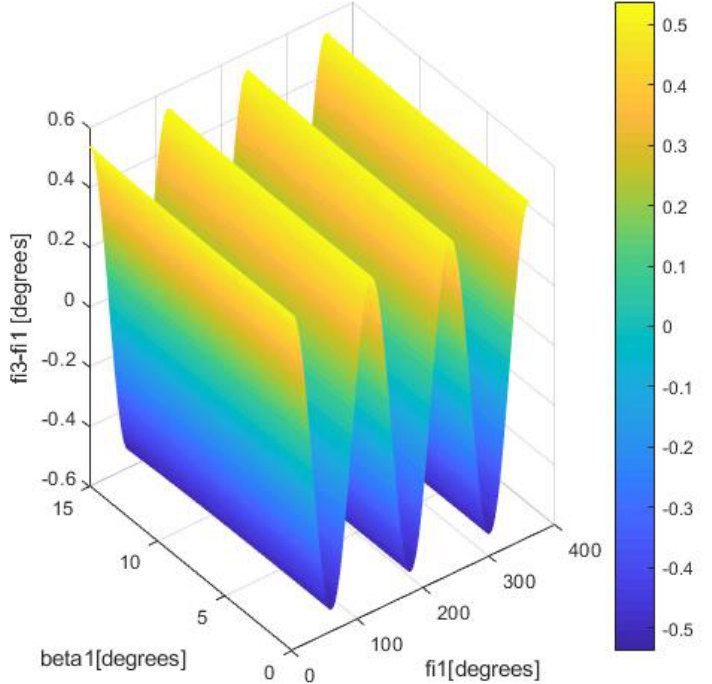
Figure 10. Geometrical nonuniformity of isometry for automotive driveshaft for r 1 /l = 0.11, r 2 /l = 0.09, β 1 = 15°.